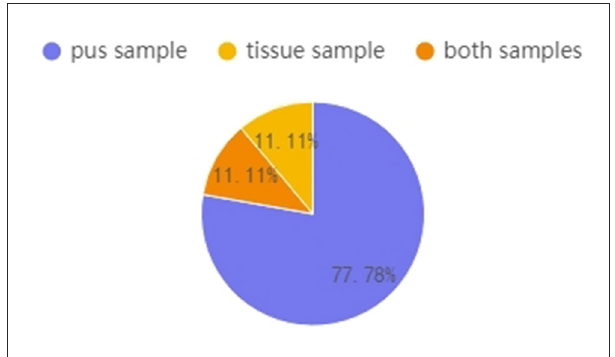
FIGURE5 Patients who had multiple samples collected ( n = 9). Percentages represent the proportions of C-positive and C-dominant samples from the nine GM